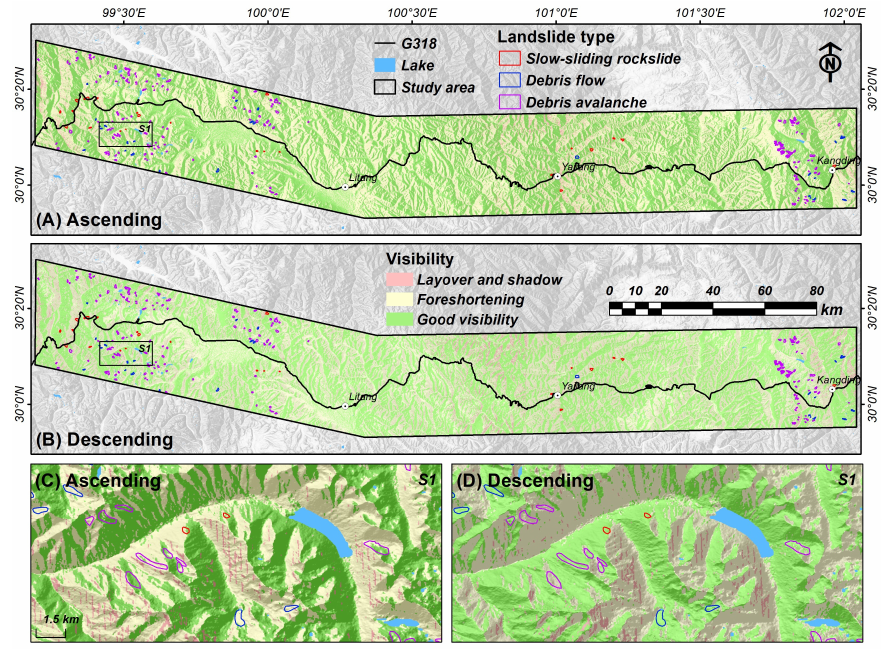
Figure 10. Terrain visibility analysis of the study area. The base map is the hillshade data calculated from the DEM.